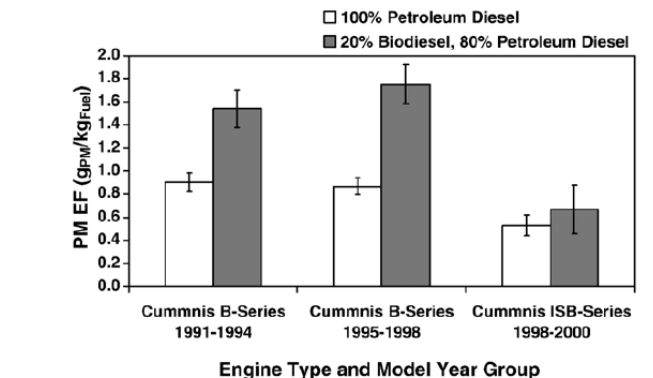
Figure 13. Particulate matter (PM) emission factors (EFs) for school buses with cold-start engine conditions stratified by model year (panel ( a )) and engine type (panel ( b ))